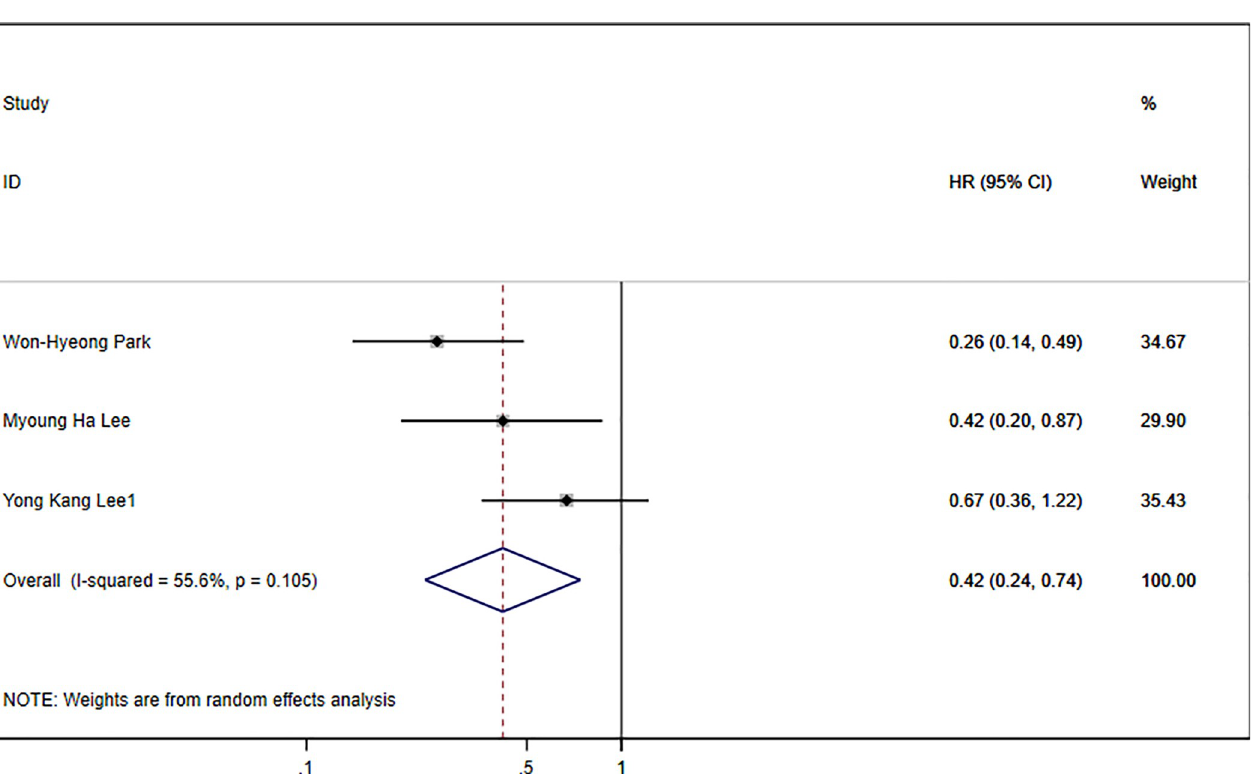
Fig 6. Forest plot of three studies with HR of DCP response for